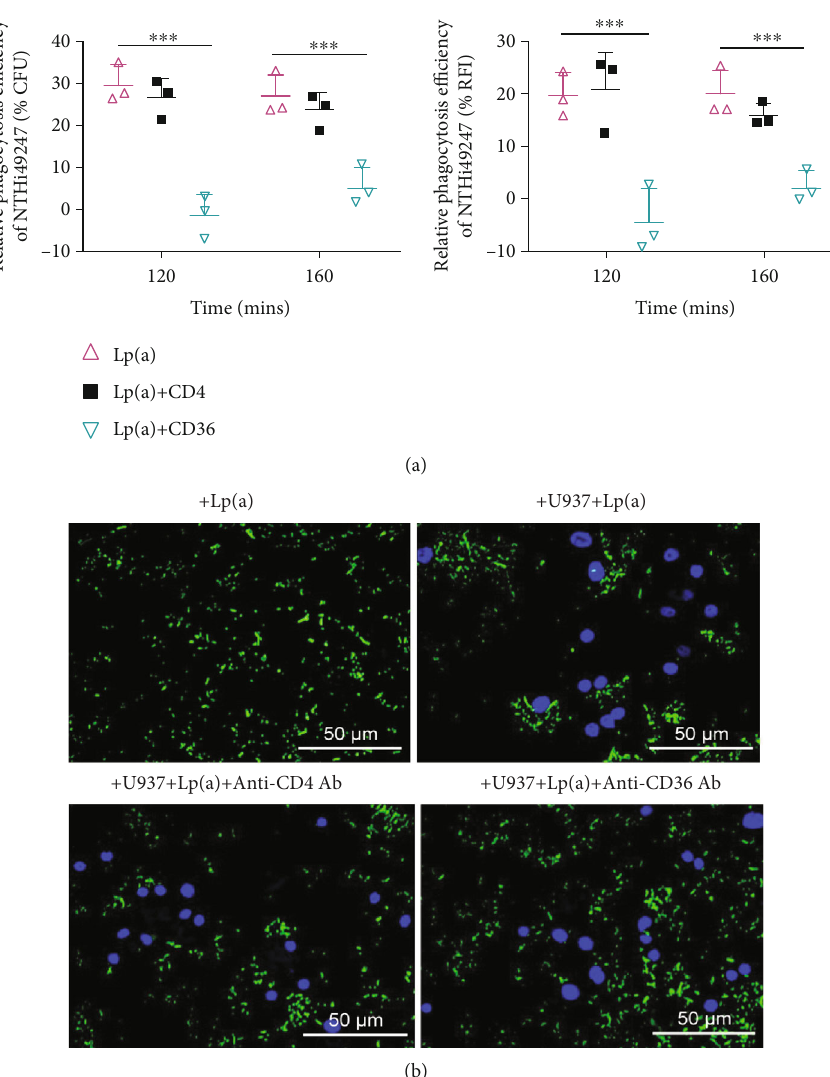
Figure 5: Treatment with an anti-CD36 antibody abrogated Lp(a)-mediated phagocytosis. (a) Phagocytosis e ffi ciency was determined by CFU counts, RFI values, and (b) fl uorescence micrographs. The MOI of NTHi49247 was 68:1. The study was repeated three times, with each treatment performed in triplicate. Data are shown as means ± SD . Statistical signi fi cance of the di ff erences between groups was estimated using two-way ANOVA and the Bonferroni post hoc test. ∗∗∗ P < 0 : 001